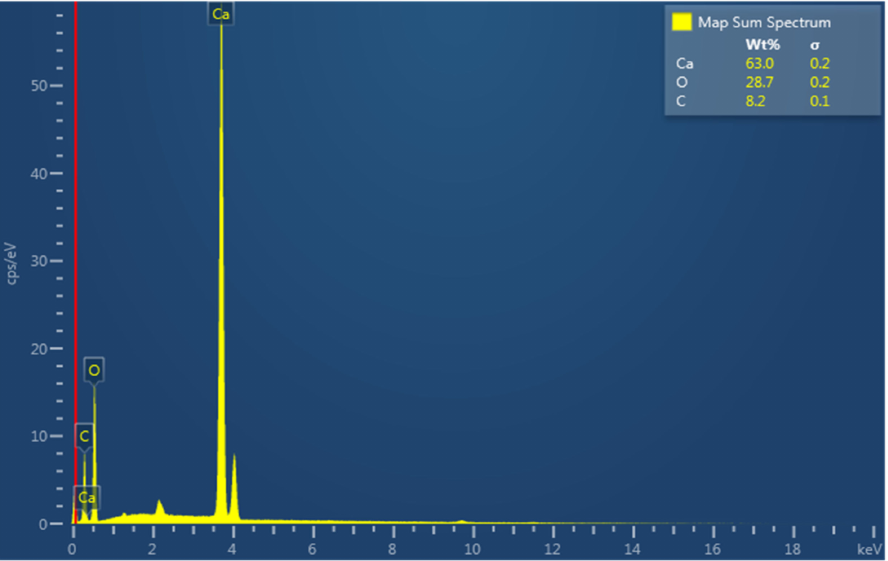
Figure 2. EDS analysis, showing the composition of the rock